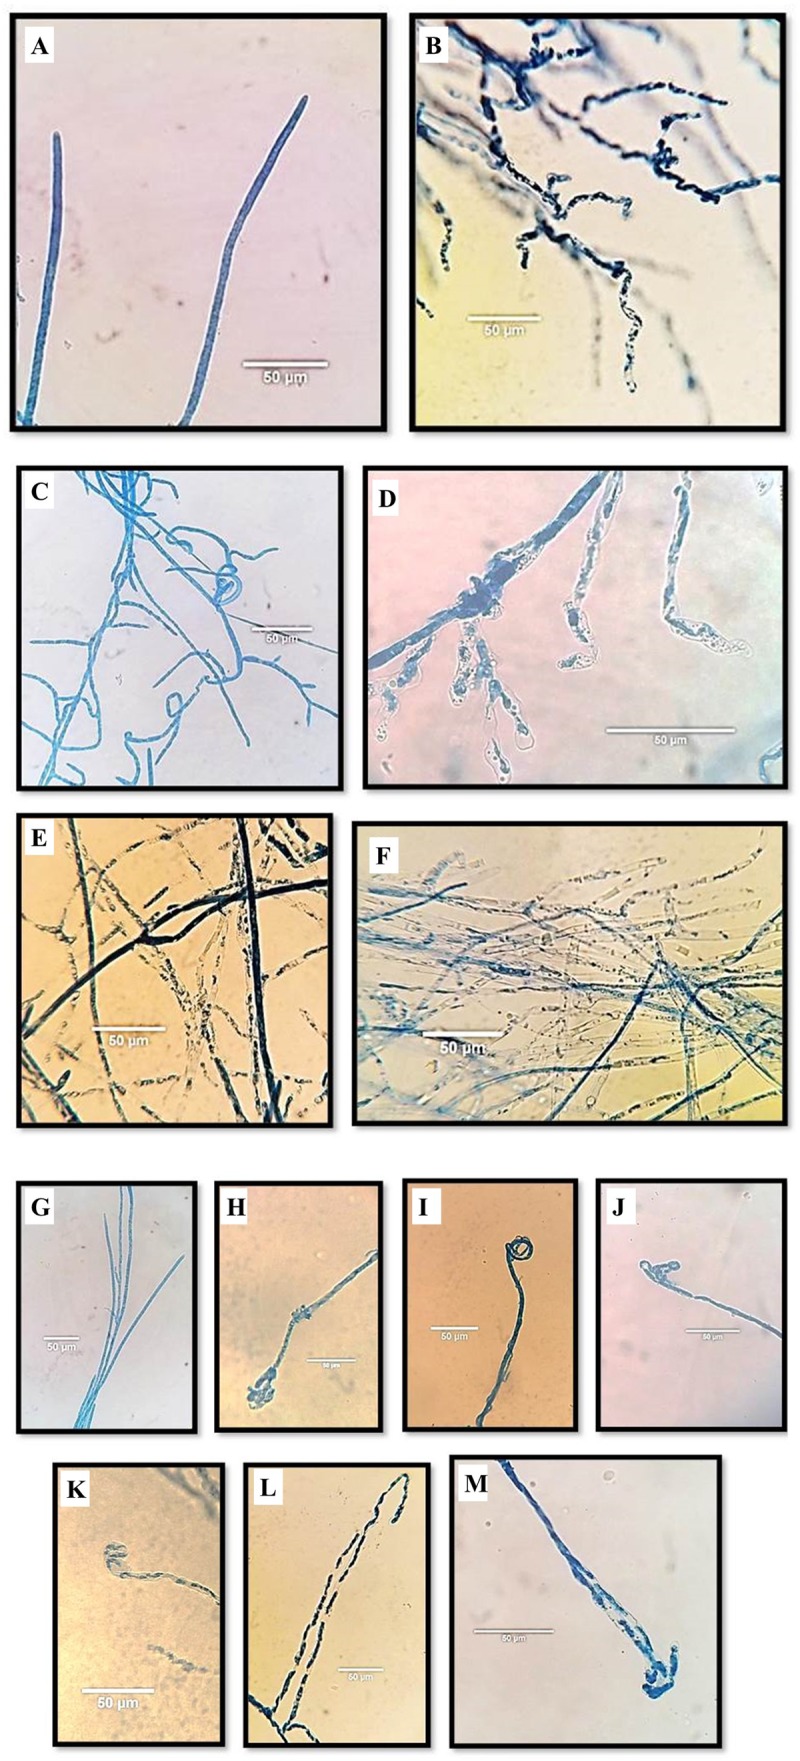
Effect of Aspergillus terreus 65P and 9F isolates on Pythium aphanidermatum morphology using light microscope. Normal general shape in control plate (A) vs. disintegrated/wavy hyphae (B); (C) the normal internal content; (D) abnormal hyphae: semi-empty pattern with content degradation under influence of 9F treatment, and abnormal hyphae: pale granular, semi empty and empty under influence of 65P (E) and 9F (F) treatments consecutively; (G) normal ends in control plate (no treatment); (H,I) wrapped up end under effect 65P treatment; (J) wrapped up end under effect 9F treatment; (K) swollen end under effect 9F treatment and (L,M) hook-like end under effect of 65P and 9F treatments, consecutively.